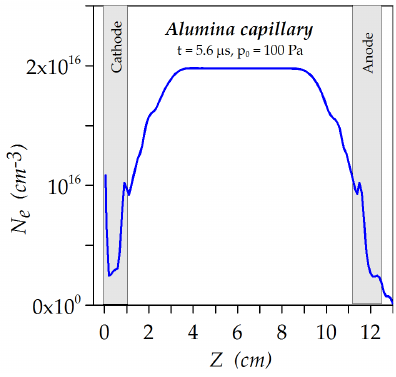
Figure 9. Electron density on the tube axis at 5.6 µ